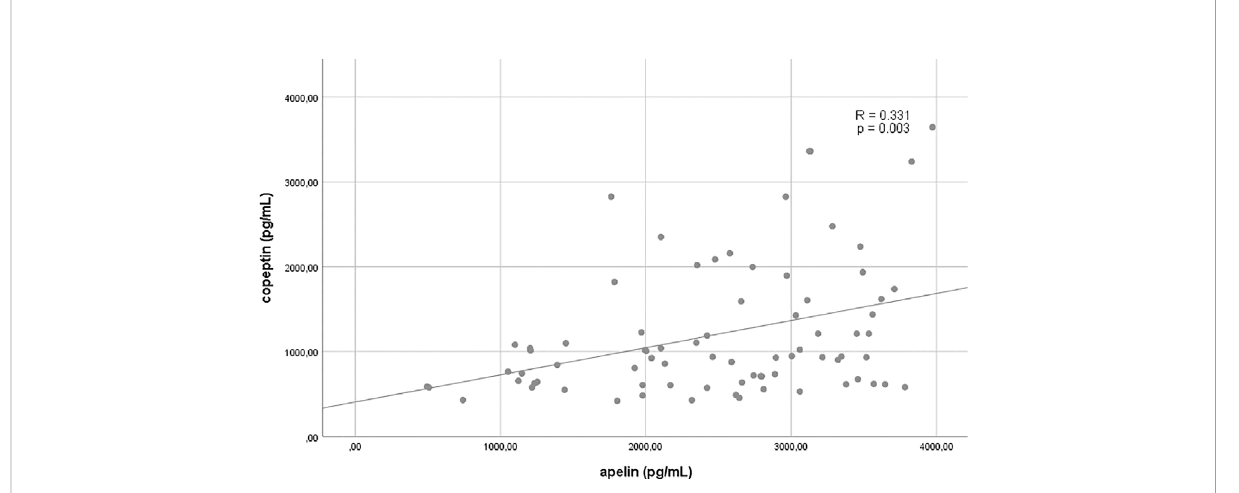
FIGURE 1 Correlation between copeptin and